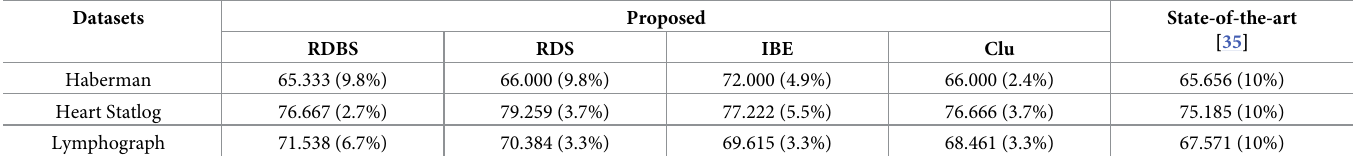
Table 9. Comparisons between our proposed and state-of-the-art active semi-supervised frameworks, considering the RF classifier for other biological datasets. For our framework, the values represent the accuracies and the percentages of labeled samples obtained by each selection strategy (note that we consider much less than 10% of the datasets). For the state-of-the-art framework, the values represent the accuracy obtained with 10% of the